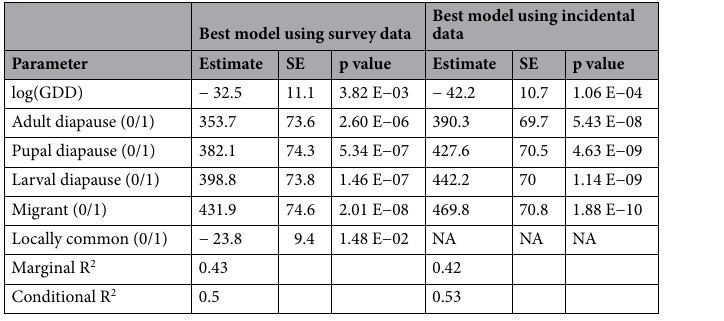
Table 1. Parameter estimates from the best 10% emergence